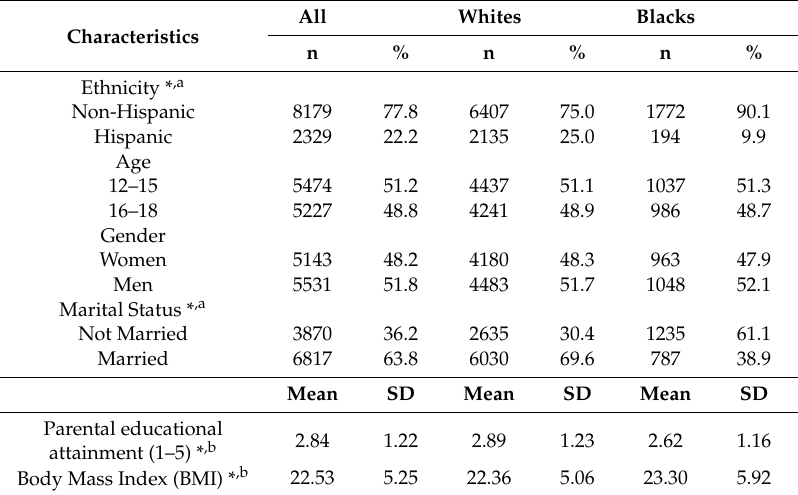
Table 1. Descriptive statistics in the complete sample and by race. Characteristics